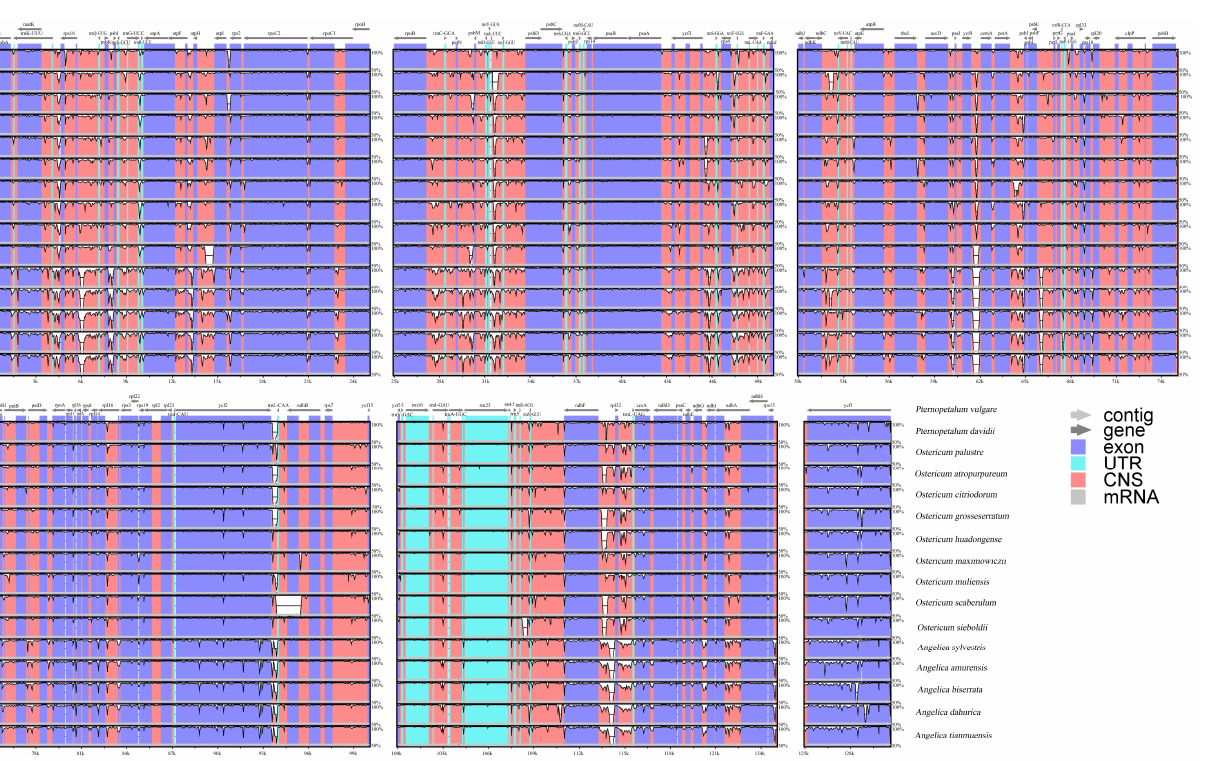
Figure 5. Sequence alignment of all the plastid genome sequences sequenced ( P. vulgare as the reference). The y-axis represents the percent similarity between 50% and 100%. Different colors represent different genetic